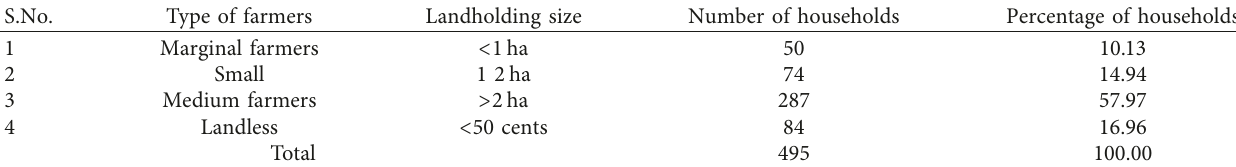
Table 1: Landholding classification in Pelasur